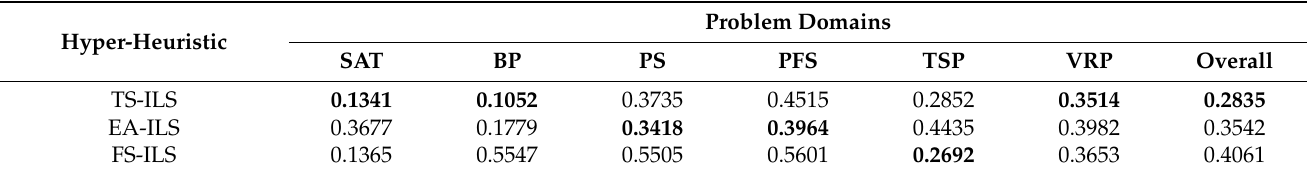
Figure 5. F1 plots of EA-ILS with other top hyper-heuristics on the HyFlex domains. The comparison of three ILS-based hyper-heuristics using a more robust µ -norm performance metric [24,25] was performed across the six domains from HyFlex v1.0. The performance metric normalizes the 31 objective function values obtained by a given hyper- heuristic, thus using the results of all 31 trials per instance as a basis for the evaluation. A fair comparison is possible based on the six domains of HyFlex v1.0 because the results for the PS achieved by the FS-ILS hyper-heuristic and the TS-ILS hyper-heuristic were based on the updated library for the domain. Table 13 summarizes the benchmarking of the performance of the EA-ILS hyper-heuristic with the results obtained by the FS-ILS and TS-ILS hyper-heuristics on the original six problem domains. Table 13. Benchmarking EA-ILS with FS-ILS and TSILS on the six domains of HyFlex v1.0 using the µ -norm